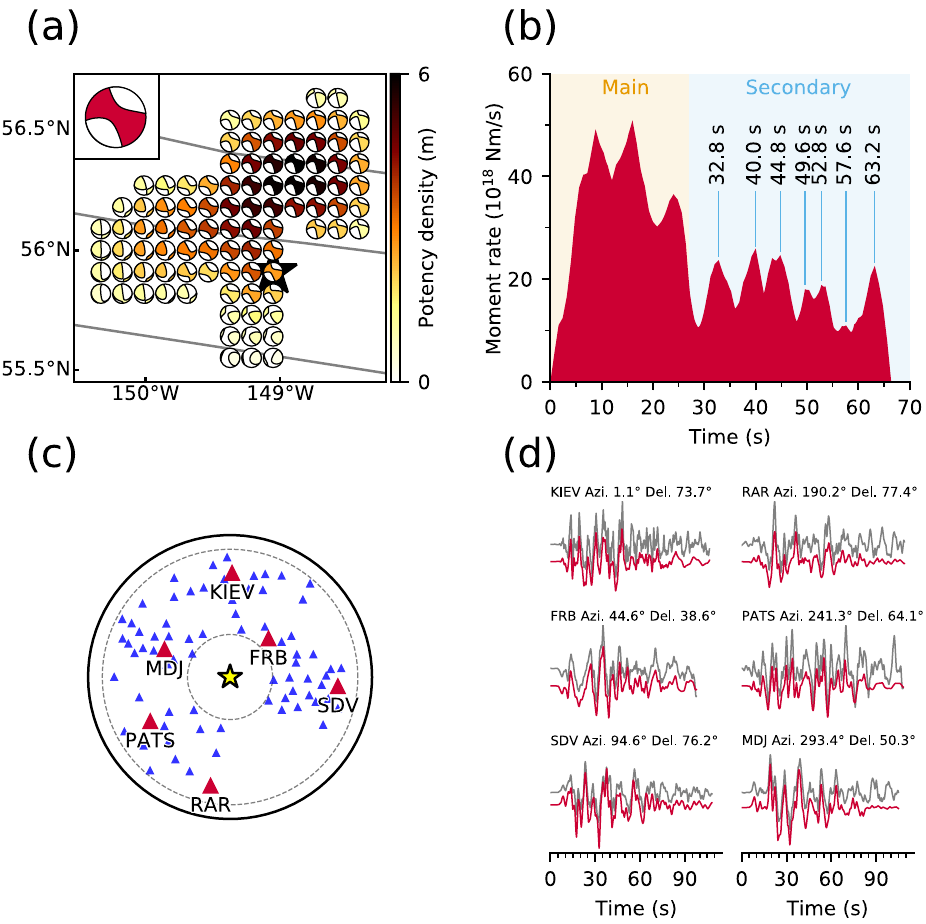
Figure 2. Model setting and summary of results. ( a ) Map projection of the potency density tensor distribution on the assumed model plane. The star and solid lines indicate the epicenter 1 and fracture zones 19,20 , respectively. Inset is the total moment tensor. ( b ) The moment rate function is divided into the main and secondary rupture stages at 27 s. The individual peaks during the secondary stage correspond to snapshots in Fig. 3b. ( c ) Azimuthal equidistant projection of the station distribution used in the inversion. The star denotes the epicenter, and triangles denote station locations (waveforms for red stations are shown in ( d )). The inner and outer dotted lines show epicentral distances of 30° and 90°, respectively. ( d ) Comparison of observed waveforms (gray) with synthetic waveforms (red) at the selected stations in ( c ). Each panel is labeled with the station name, azimuth (Azi.), and epicentral distance (Del.) from the mainshock. Waveform comparisons for all stations are shown in Supplementary Fig. S11. This figure was made with matplotlib (v3.1.1) 48 and ObsPy (v1.1.0) 49